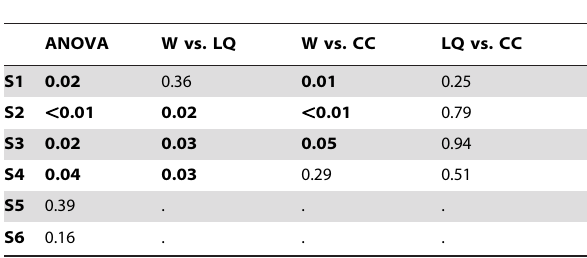
Table 1. Statistical comparison of SN number across groups.